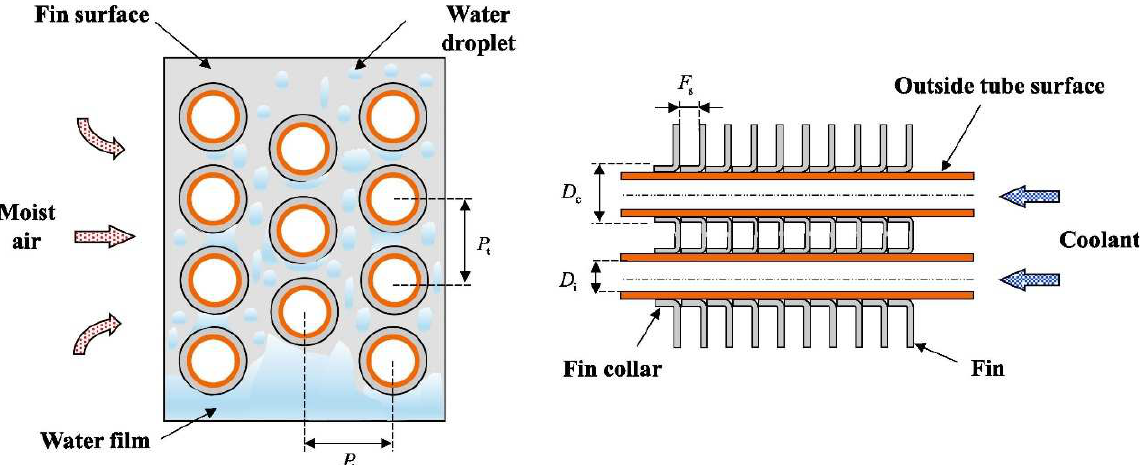
Figure 5. Schematic representation of the cross-section of a fin-and-tube heat exchanger. It also includes certain geometric features. Reproduced with permission from Guohui Zhang, Baolong Wang, Xianting, Li, Wenxing Shiab, Yang Cao, Applied Thermal Engineering Journal, published by Elsevier, 2019 [118].